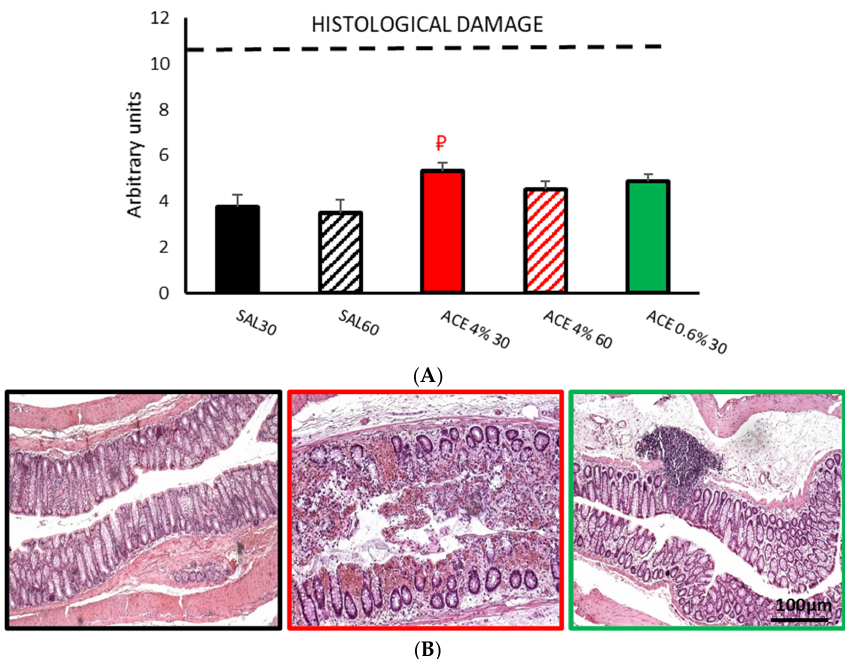
Figure 3. Effect of intracolonic administration of acetic acid on histological damage of colonic wall, phase I (model selection). Histological damage ( A ) was measured in ten random fields per section. Maximum damage was represented by 11 points (dotted line). Experimental groups: SAL30, black bar; SAL60, black striped bar. ACE 4% 30, red bar; ACE 4% 60, red striped bar; ACE 0.6% 30, green bar. Data represent mean ± SEM. ₽ p < 0.05 vs. SAL60. One-way ANOVA followed by Bonferroni post hoc test. ( n = 8–13). ( B ) Photomicrographs of colonic samples stained with H/E after intracolonic administration of SAL30 (black frame), ACE 4% 30 (red frame), or ACE 0.6% 30 (green frame). Scale bar = 100 μm.